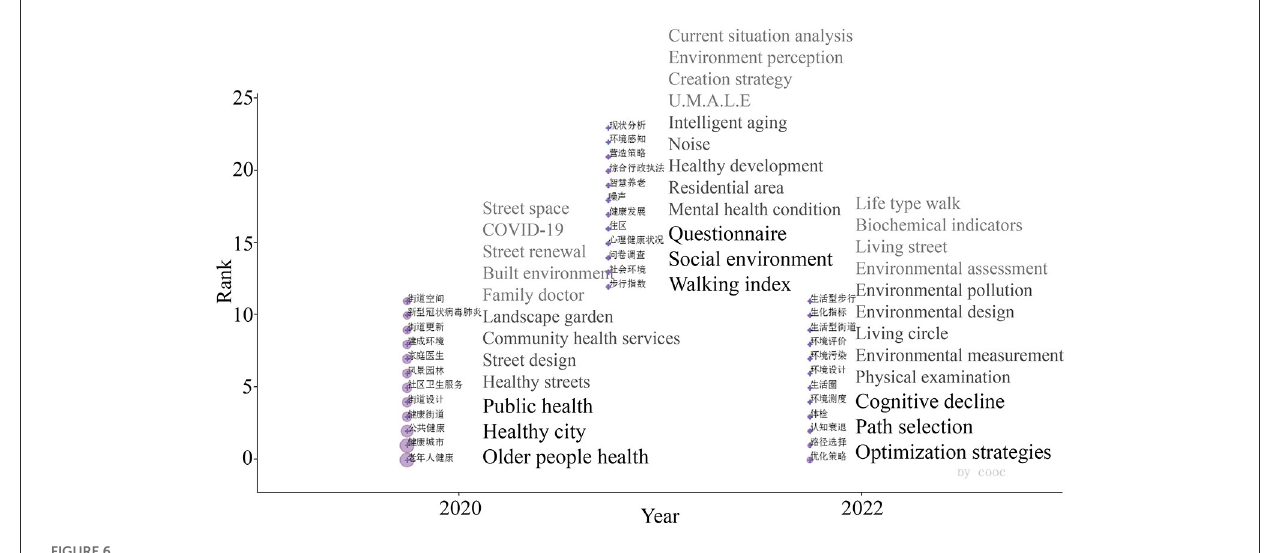
FIGURE6 Cumulative time zone diagram of the evolution of research themes 2020–2022.